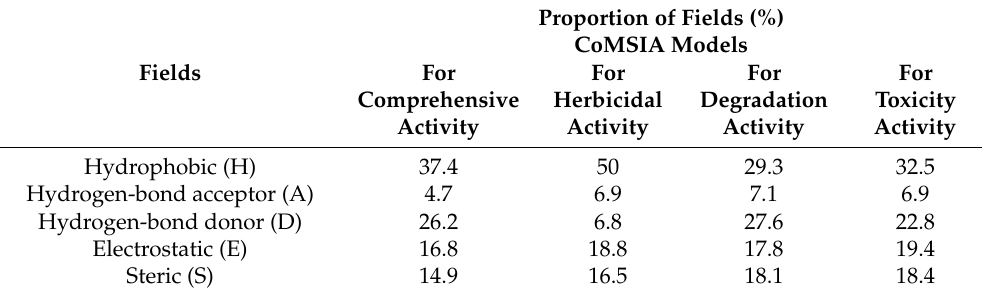
Table 2. The proportion of each force field in the single-effect and comprehensive-effect CoMSIA models of herbicidal functionality properties, degradability, and toxicity of S-THs based on the 3D isopotential diagrams. Proportion of Fields (%) CoMSIA Models For For For For Fields Degradation Herbicidal Comprehensive Activity Activity